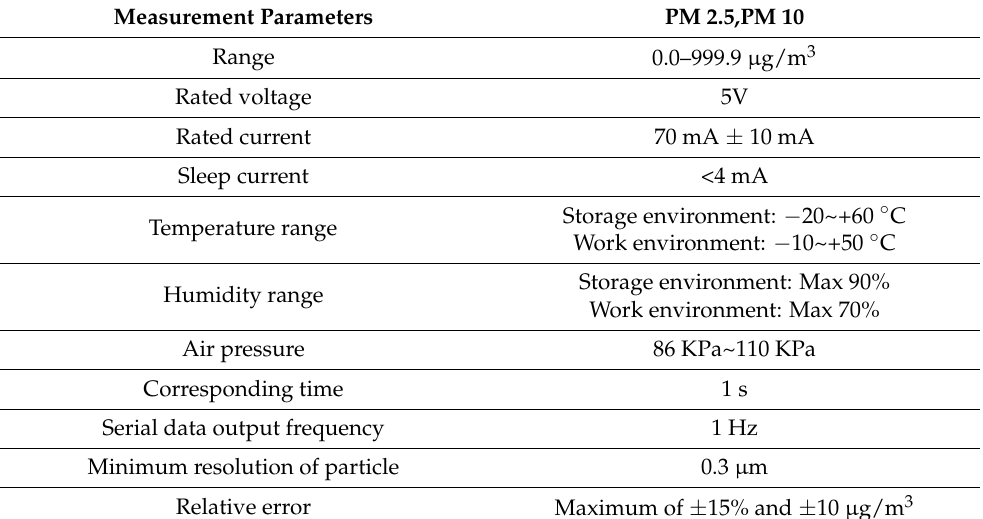
Figure 5. SDS011 sensor. Table 2. Main parameters of the SDS011